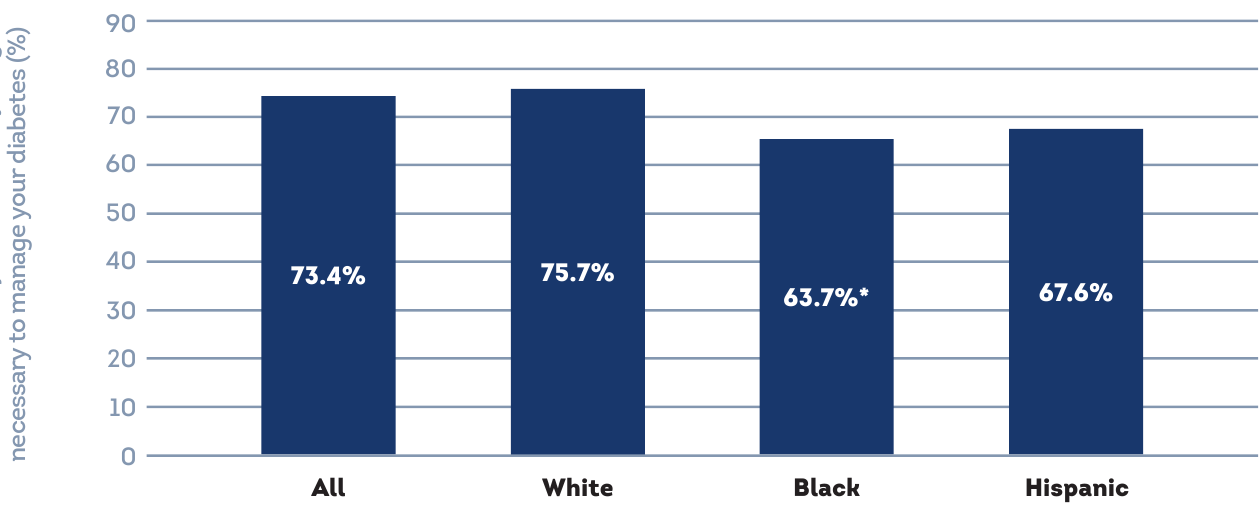
Figure 4. Percentage reporting that they know most or just about everything necessary to manage their diabetes, among community-dwelling Medicare beneficiaries with self-reported diagnosed diabetes, by race/ethnicity